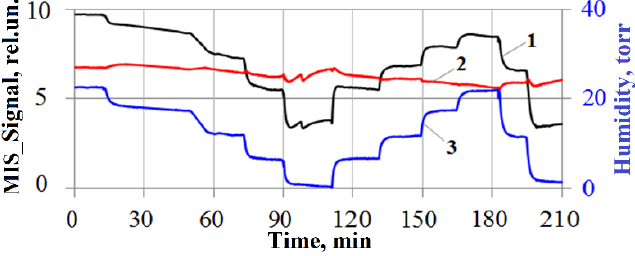
Figure 4. Compensation of the readings of the MIS sensor for humidity: curve (1) the initial MIS_Signal, (2) MIS_Signal_Compensated, (3) water vapor pressure.